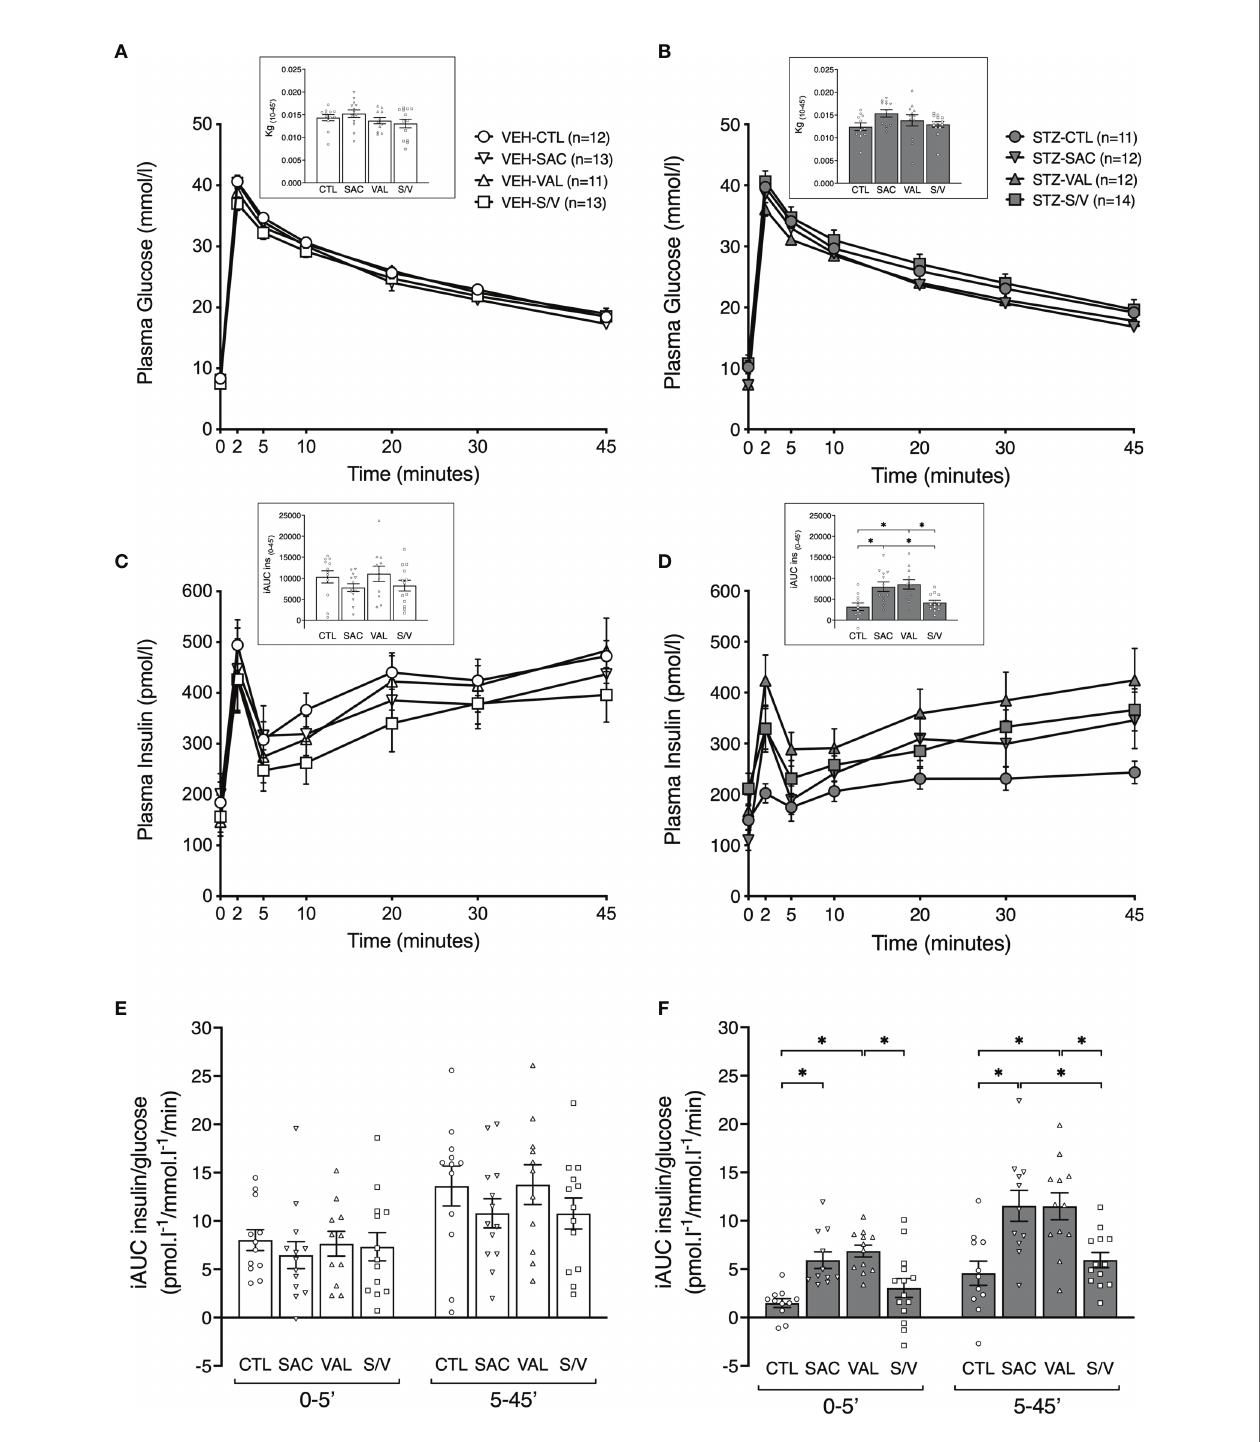
FIGURE 3 | Sacubitril and valsartan but not sacubitril/valsartan increase glucose-stimulated insulin secretion in diabetic mice. Plasma glucose (A, B) and insulin (C, D) during an IVGTT in vehicle [ (A, C) VEH]- and streptozotocin [ (B, D) STZ]-injected high fat-fed mice treated for 8 weeks with control (circles; CTL), sacubitril (inverted triangles; SAC), valsartan (triangles; VAL) or sacubitril/valsartan (squares; S/V). The insets in A and B represent the rate of glucose disappearance (Kg) computed from 10 to 45 minutes during the IVGTT. The insets in C and D represent the incremental areas under the curve (iAUC) for insulin from 0 to 45 minutes. First-phase [0-5 ’ ] and second-phase [5-45 ’ ] glucose-stimulated insulin secretion (E, F) during the IVGTT in VEH (E) - and STZ (F) - injected mice treated for 8 weeks with CTL, SAC, VAL or S/V. n=11-14/group.